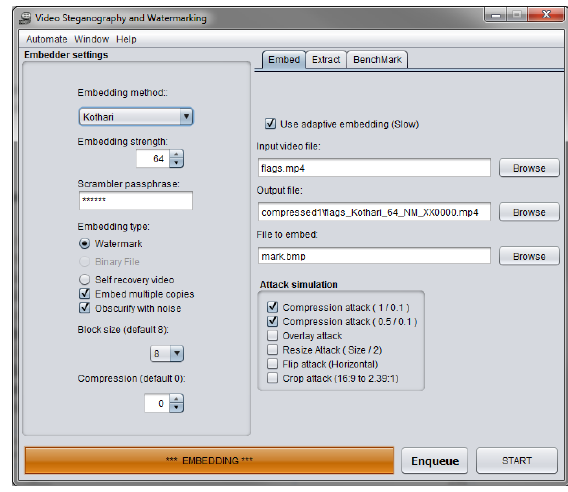
Fig. 3. Main window of the program